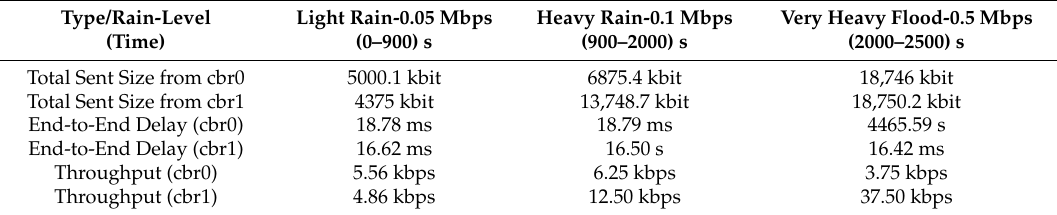
Table 5. Performance measurements before and during the time when node 1 is affected by rain.